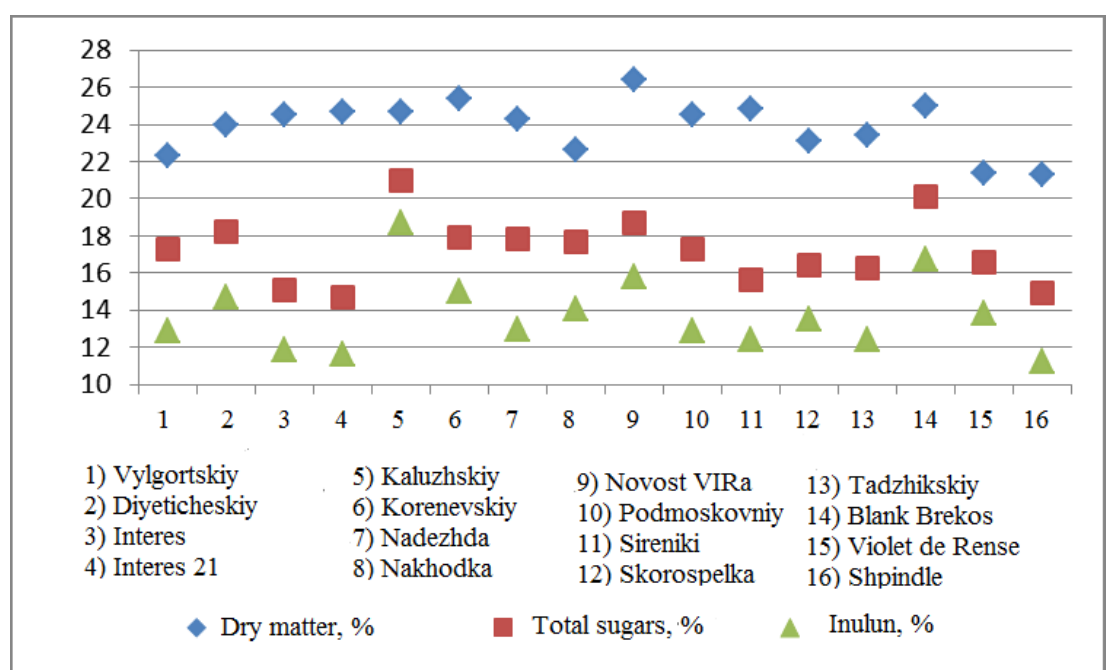
Figure 6. Content of dry matter, total sugars, and inulin in tubers of the varieties tested. The technological qualities of raw artichoke tubers were assessed (Figure 7).